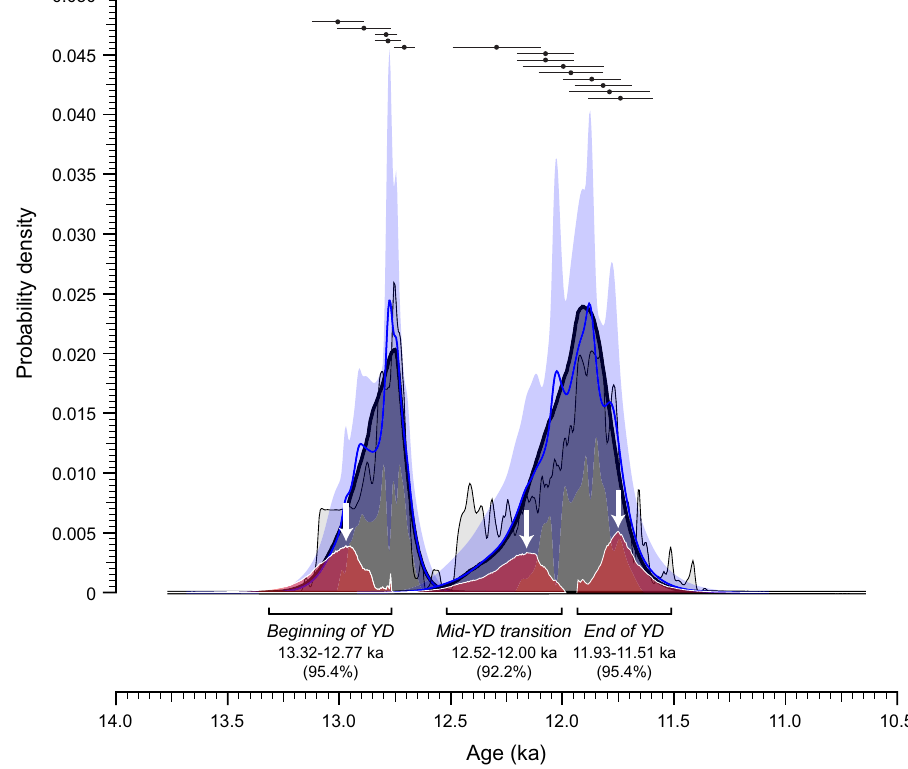
Figure 3. Kernel density estimate (KDE) modeling results for the calibrated 14 C ages (filled dark circles with uncertainties presented at the 95% (2σ) confidence level). The KDE distribution is shown in dark gray outlined in black. The blue line and lighter blue band show the mean and ± 1σ for snapshots (n = 1000) of the KDE distribution, which give an indication of the significance of individual features. The Sum distribution is shown in light gray and the start and end of the Boundary distribution are in red. The white arrows show the maximum probability density for the beginning (~ 13.0 ka) and end (~ 11.8 ka) of the YD sedimentary sequence, as well as the transition between the two phases of sedimentation (~ 12.2 ka). Generated using the KDE_Model and 32 and the IntCal20 calibration curve 40 ; accessed online Boundary functions in OxCal v.4.4.2 r:5